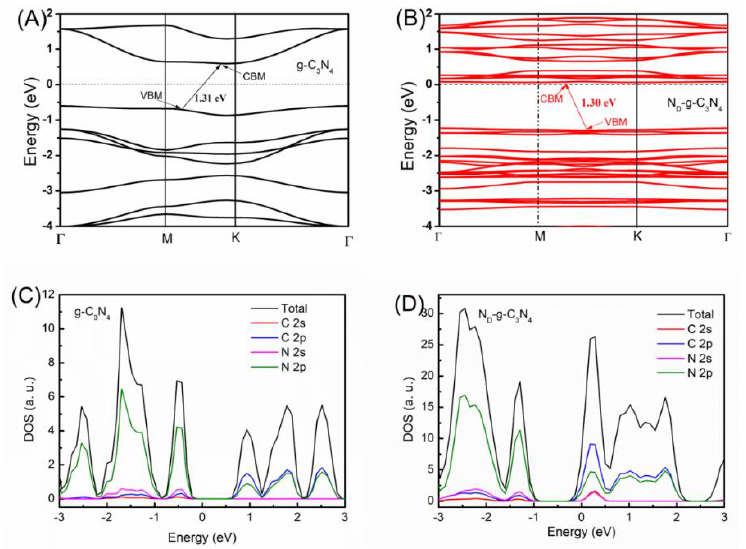
Figure 7. Calculated band structure of ( A ) g-C 3 N 4 , ( B ) N D -g-C 3 N 4 ; Calculated DOS of ( C ) g-C 3 N 4 , ( D ) N D -g-C 3 N 4.